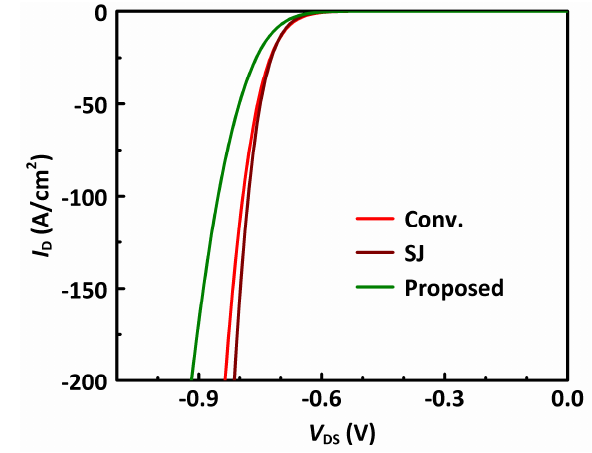
Figure 7. The reverse conduction characteristics of the studied MOSFETs.